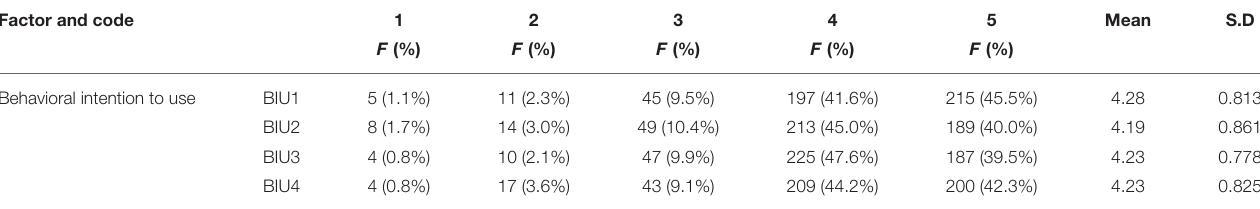
TABLE 11 | Measuring behavioral intention to use (BIU).